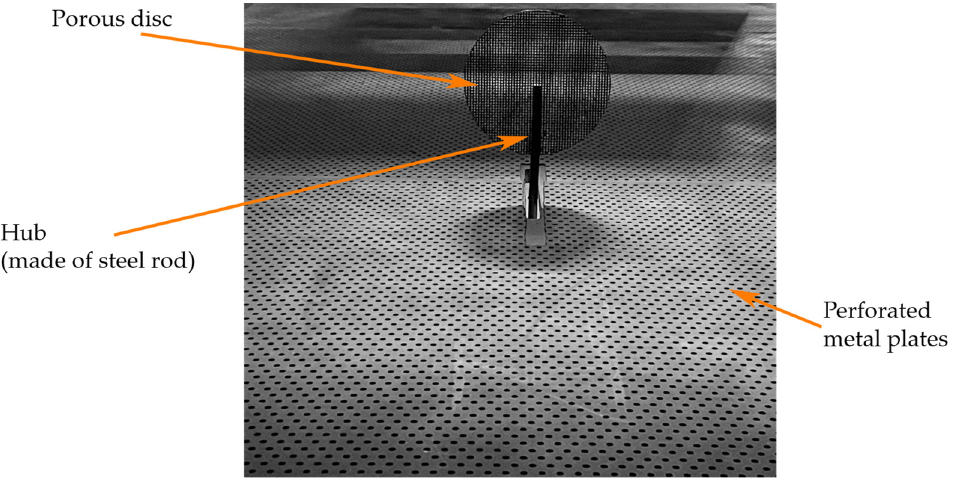
Figure 2. Porous disc model of the studied wind